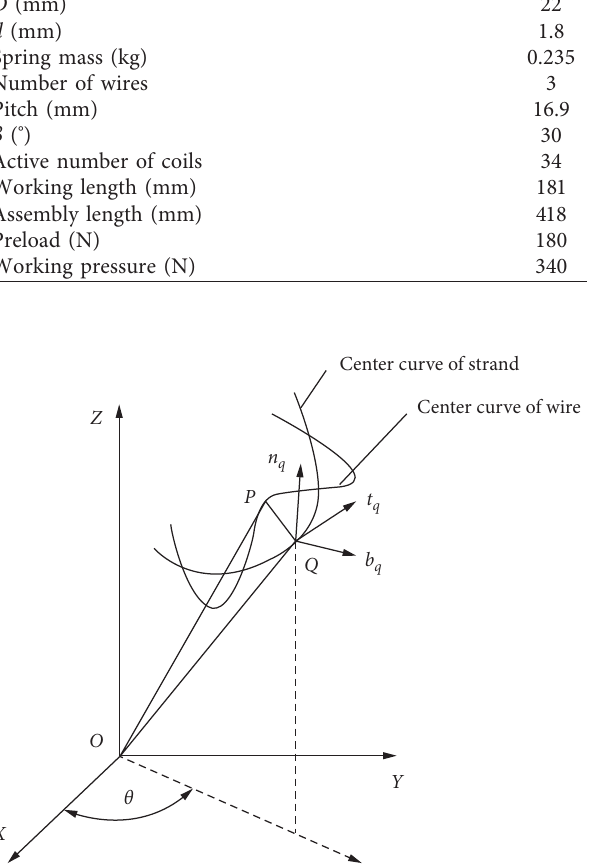
Figure 2: The center curves of strand and wire of recoil